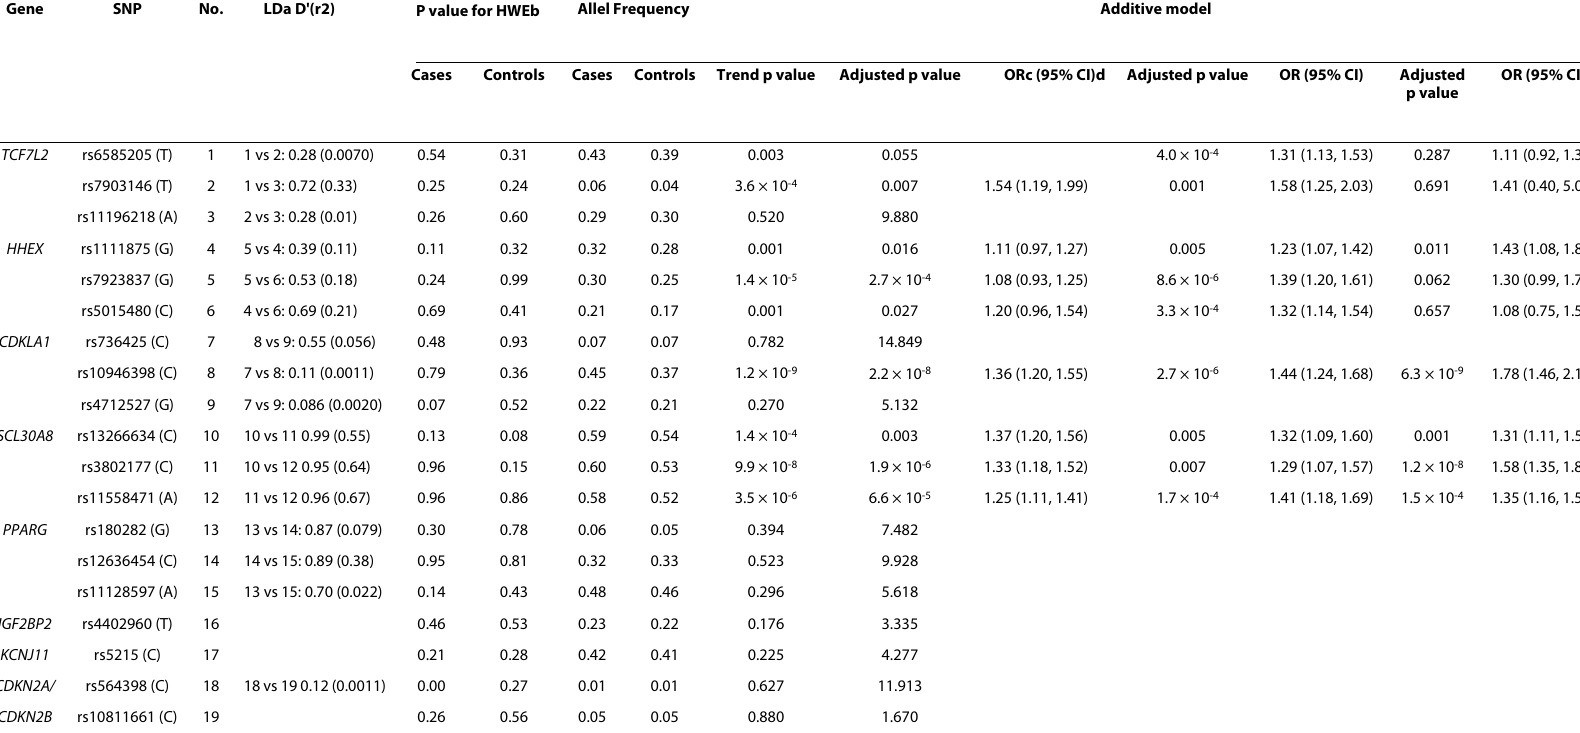
Table 3: Association between type 2 diabetes and 19 SNPs in the eight genes/loci Gene SNP No. LDa D'(r2) P value for HWEb Allel Frequency Additive model Cases Controls Cases Controls Trend p value Adjusted p value